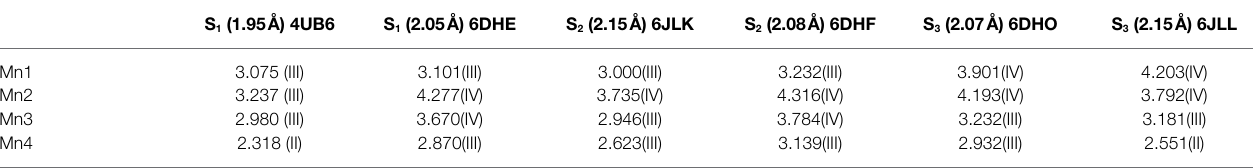
Roman numerals in parentheses indicate the assignment of the oxidation state of Mn ion based on BVS calculation. All atomic coordinates used for BVS calculation were taken from the first monomer of PS II in the crystal structure data with PDB-IDs: 4UB6 (Suga et al., 2015), 6DHE (Kern et al., 2018), 6DHF (Kern et al., 2018), 6DHO (Kern et al., 2018), 6JLK (Suga et al., 2019), and 6JLL (Suga et al., 2019),